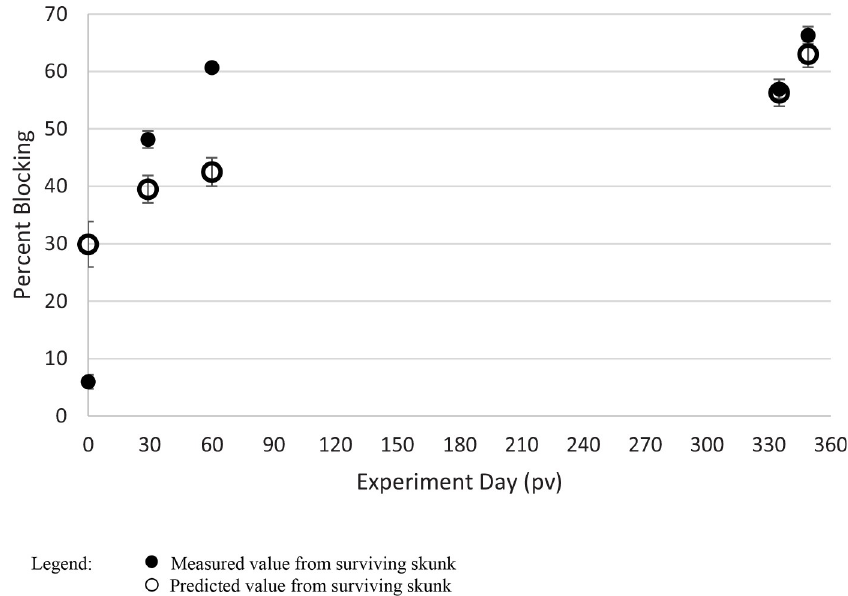
Fig 3. Measured and predicted rabies binding antibody values (rVBA) in skunks at post-vaccination (pv). Infection occurred on day 335 pv. Only one skunk from the model set died during virus challenge and was not included in the figure. Error bars represent standard